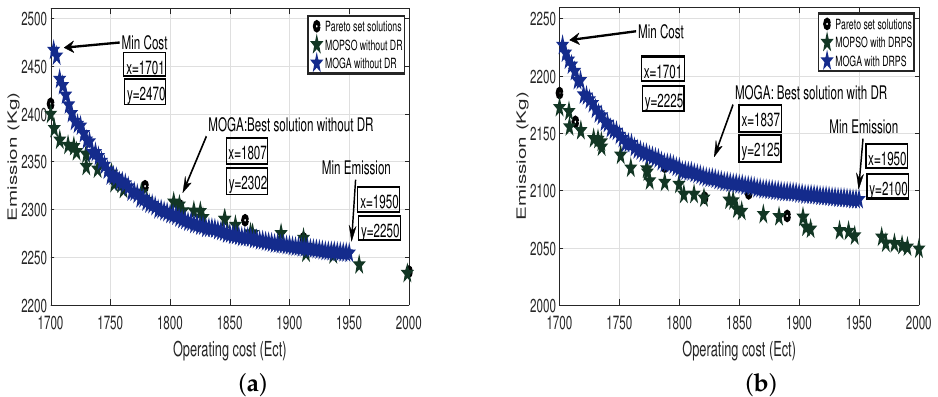
Figure 6. Multi-objective energy optimization of the proposed MOGA and existing MOPSO algorithm using Pareto-fronts criterion for operation cost and carbon emission optimization ( a ) without DRPs; ( b ) with